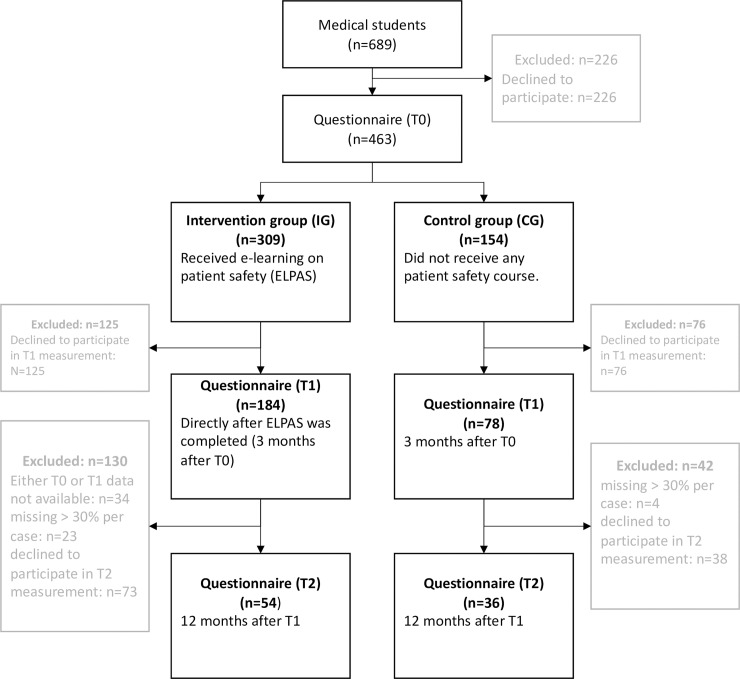
Summary of method and sample.